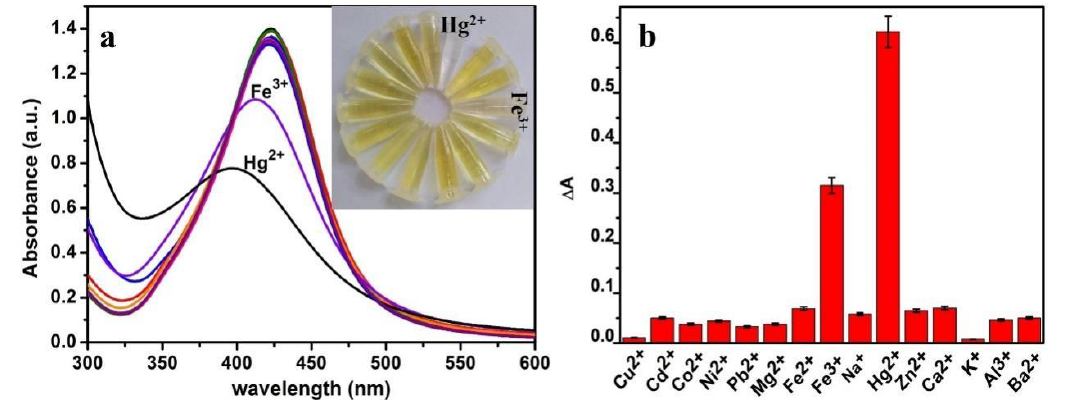
Figure 3. ( a ) UV – vis absorption spectra; and ( b ) ΔA of the proposed sensing system in the presence Figure 3. ( a ) UV–vis absorption spectra; and ( b ) ∆ A of the proposed sensing system in the presence of various metal ions. The concentrations of all metal ions were 50 μM. of various metal ions. The concentrations of all metal ions were 50 µ